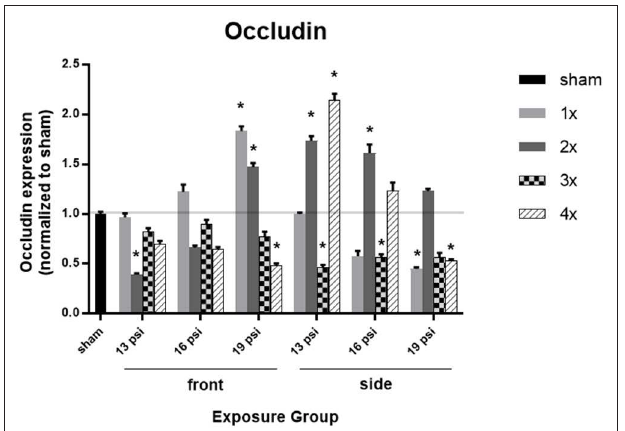
FIGURE 4 | Quantification of claudin-5 expression measured by Western blot. Results presented as blast intensity for each orientation (front vs. side). Values normalized to sham. Statistical significance compared to sham: * p < 0.05 (Significance values in Supplemental Table 3 ). Data is expressed as mean ± SEM, normalized to sham. Representative Westerns shown in Supplemental Figure 1